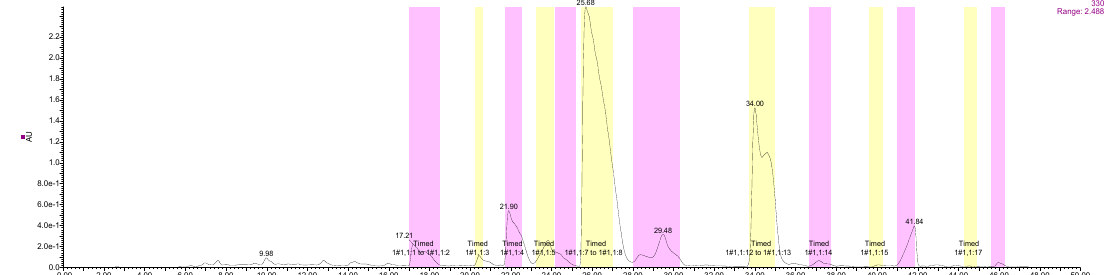
Figure 5. Collection conditions under automatic fraction trigger.